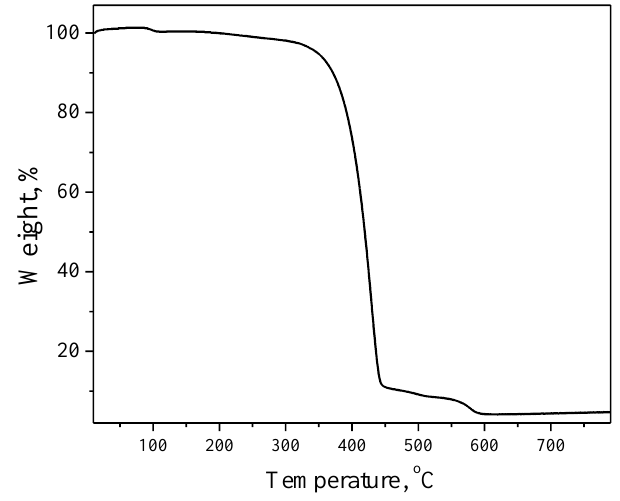
Figure 1. TGA curve of compound 7 . Heating rate: 10 °C min −1 .